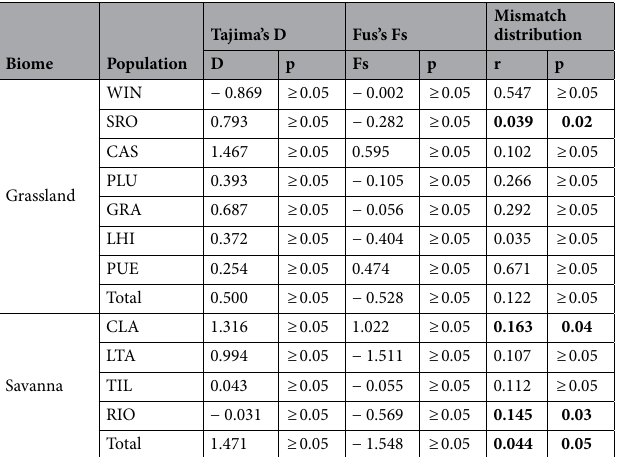
Table 4. Demographic summary statistics Tajima’s D and Fu’s FS and mismatch distribution raggedness index (r) based on mitochondrial COI sequence data of 11 populations of D. vittatus located along two Argentinian Biomes. Significant values are highlighted in